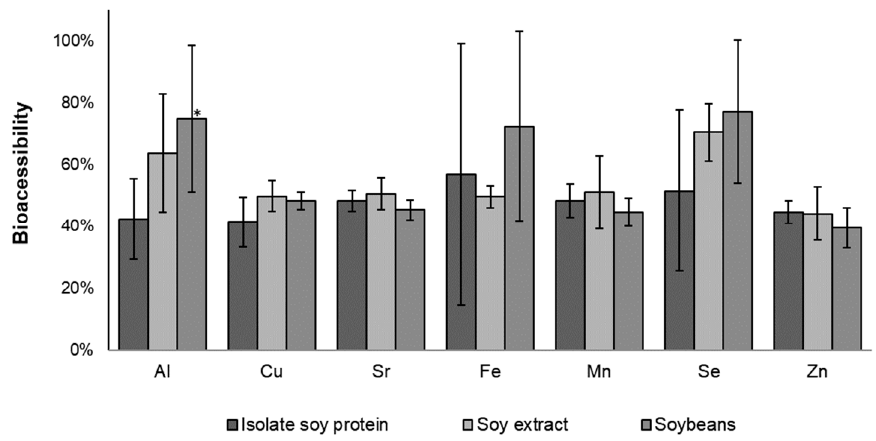
Figure 2. Trace elements bioaccessibility from soy-based beverages. * Mean values between bar with